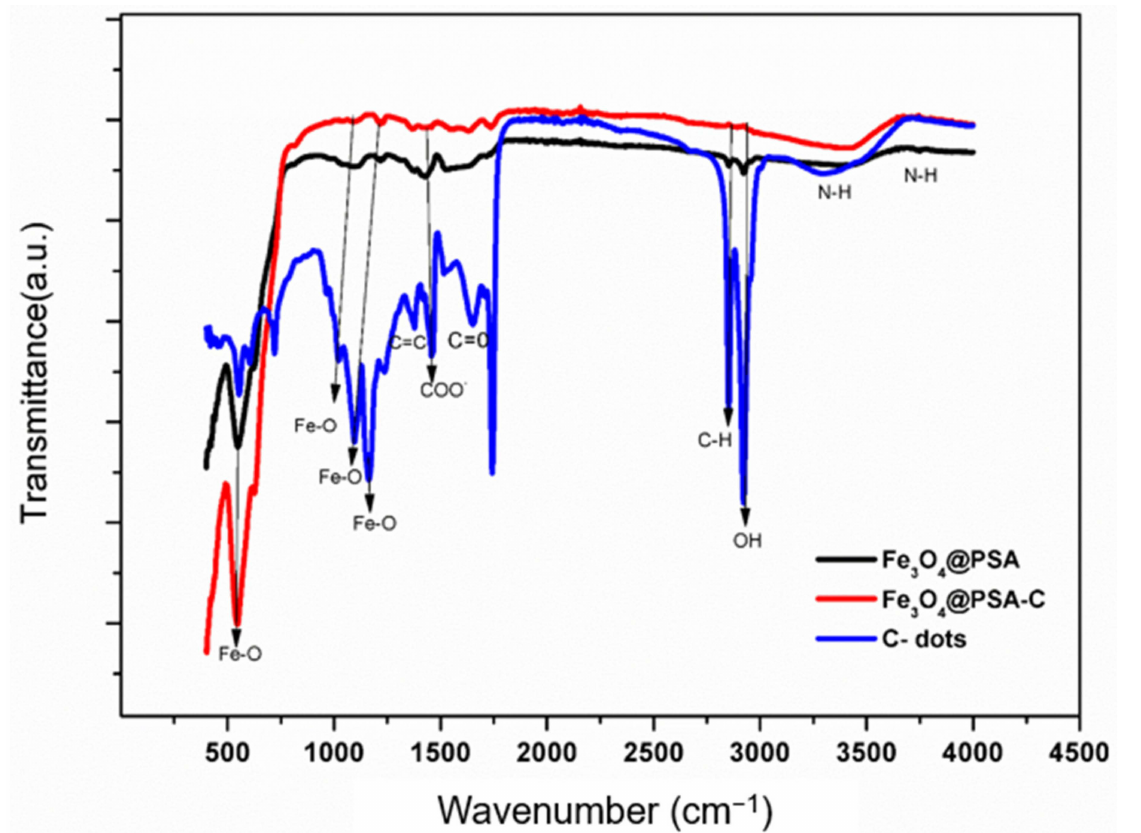
Figure 3. FTIR spectra of C-dots; Fe 3 O 4 @PSA-C and Fe 3 O 4 @PSA